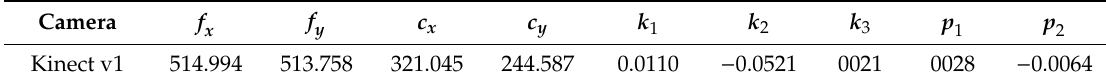
Table 2. Calibration results of RGB-D